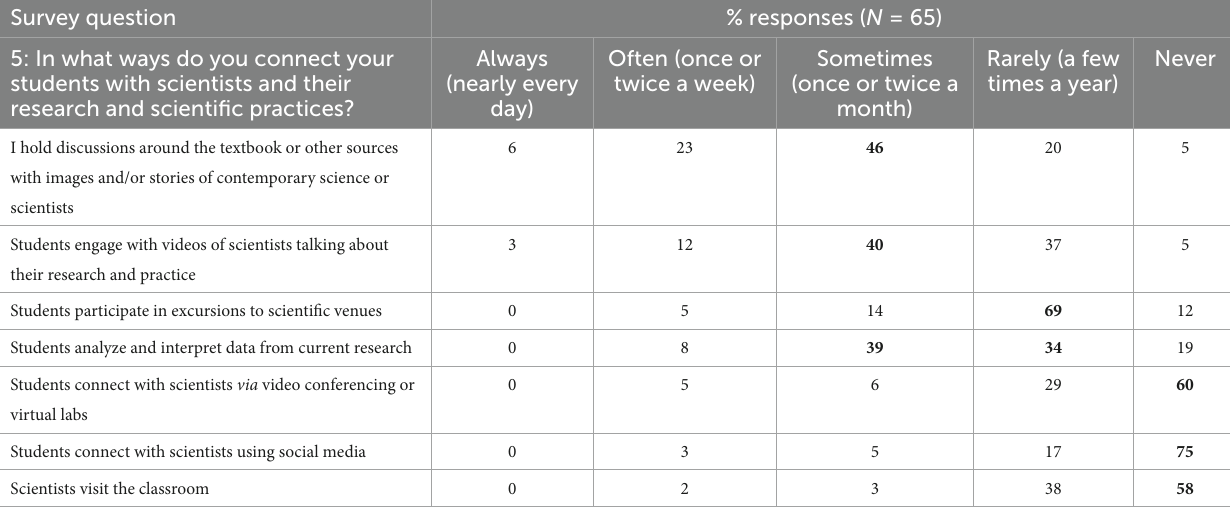
TABLE 4 Responses to survey question 5 (modal responses